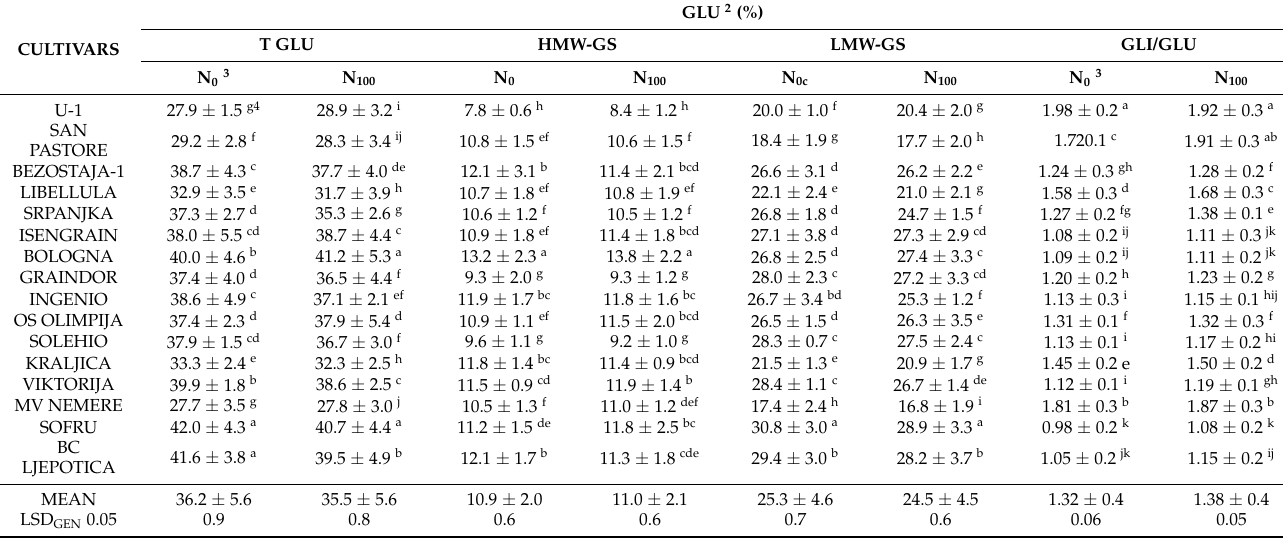
Table 4. Mean 1 values of GLU proportions in total grain protein of wheat under low and high N levels.